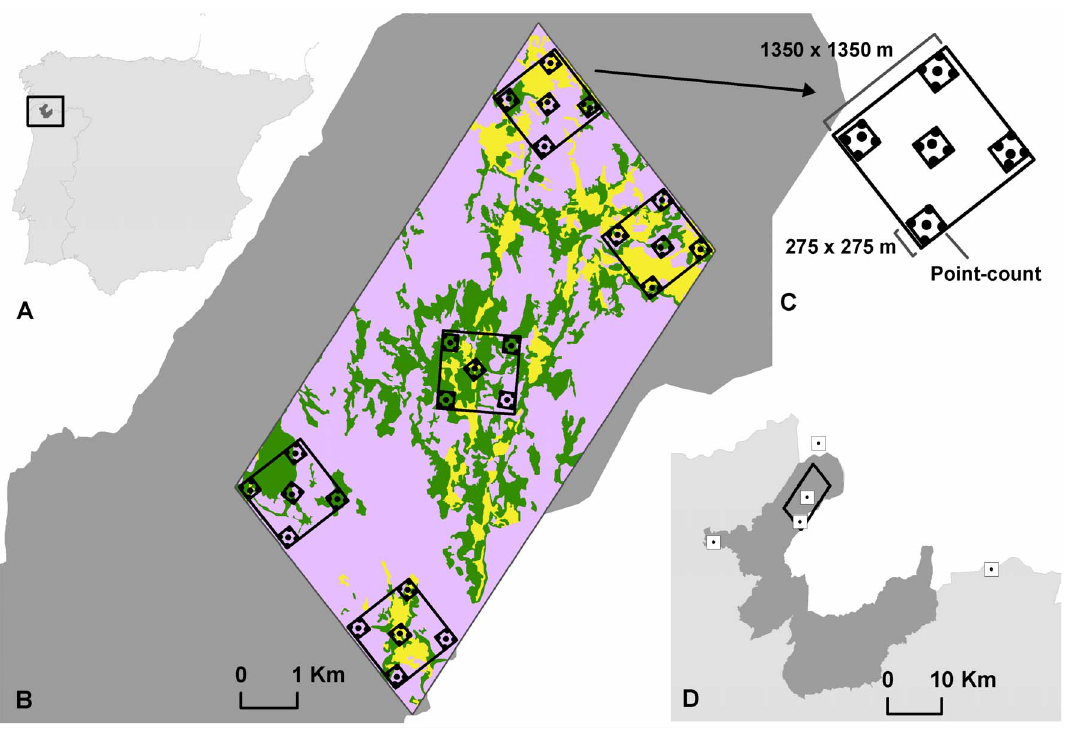
Figure 1. Map of the study region. A: Location of the study region in Northern Portugal (dark-grey area represents the Peneda-Gereˆs National Park); B: Nested sampling scheme and the three land-uses considered in the study: farmland (yellow), shrubland (rose) and oak forest (green); C: Detail of a local-square; D: Distribution of the local-squares used for the species similarity decay analysis.